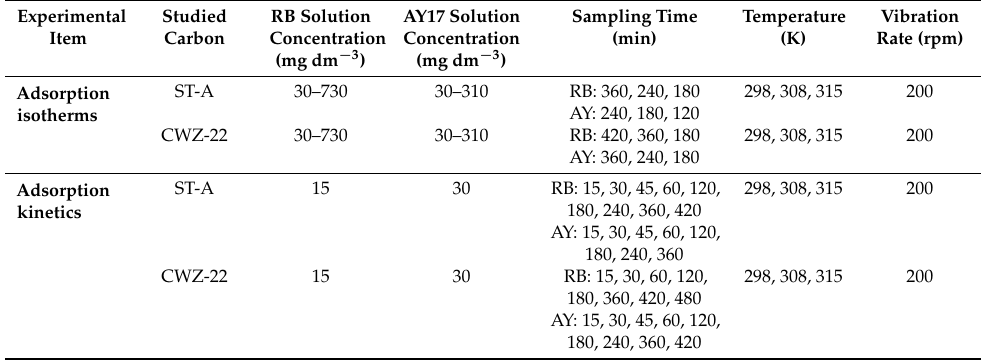
Table 1. The adsorption isotherms and kinetics—conditions and runs.